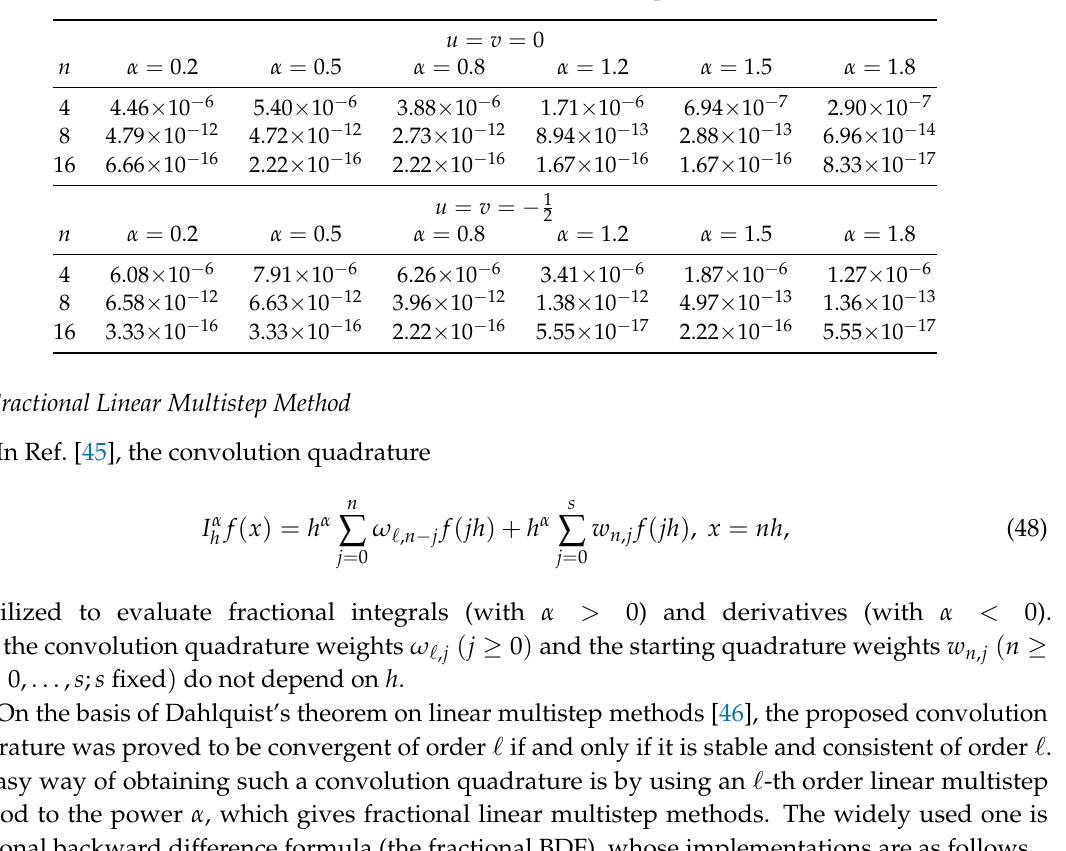
Table 2. The absolute errors for Example